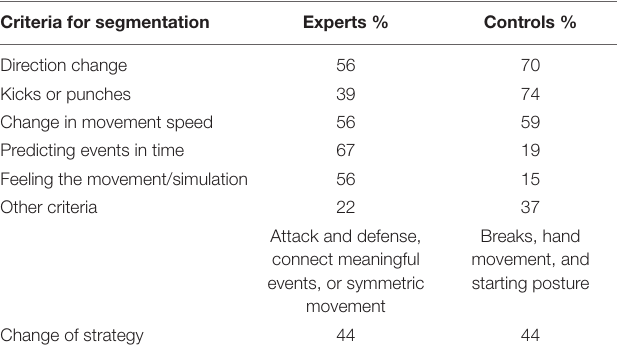
TABLE 2 | Debriefing